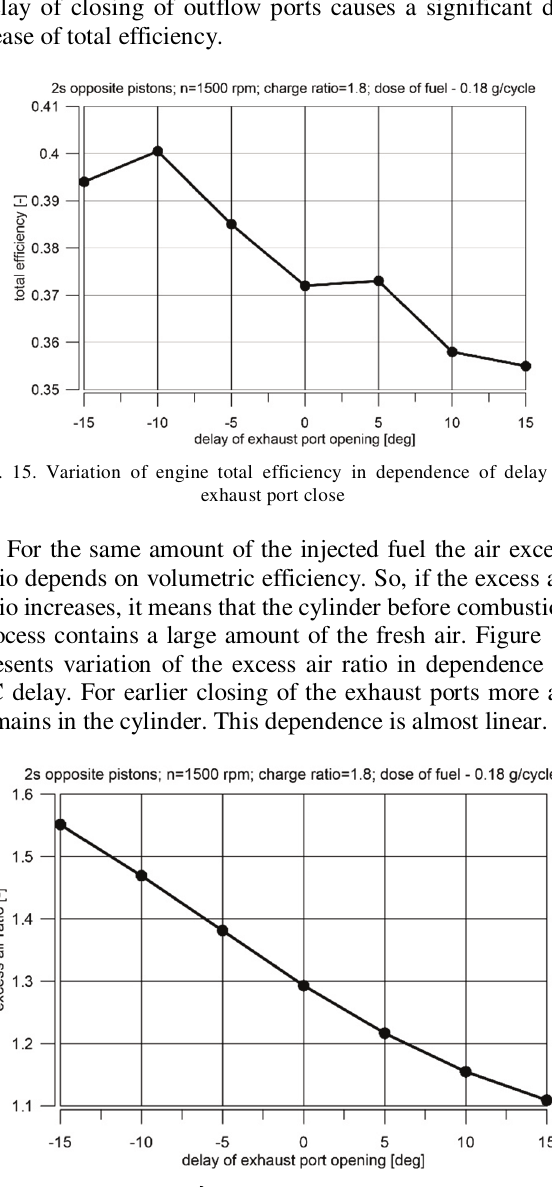
Fig. 16. Air excess ratio ( l ) as function of delay exhaust port opening